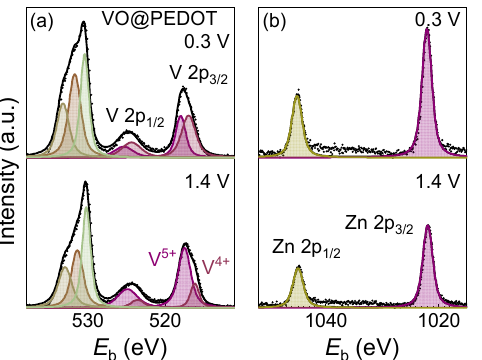
Figure 11. XPS spectra of V 2p ( a ) and Zn 2p ( b ) for VO@PEDOT electrode in the charged and discharged states.